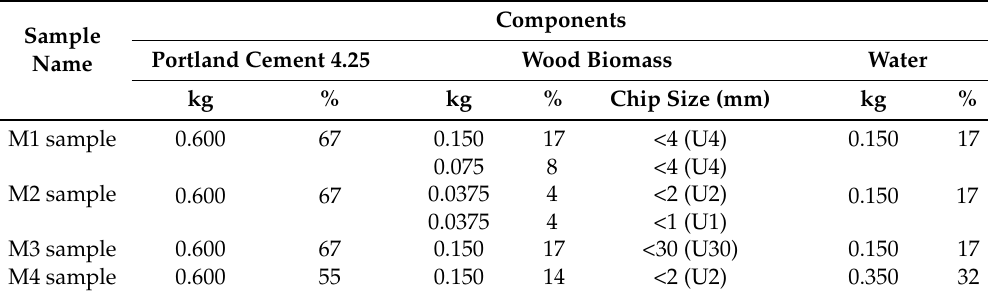
Figure 5. Mixing procedure of the mineralization process ( a ) Portland cement 4.25; ( b ) The material mixer; ( c ) The prepared samples and the moulds. Table 3. Mineralized sam ple compositions of the M series.